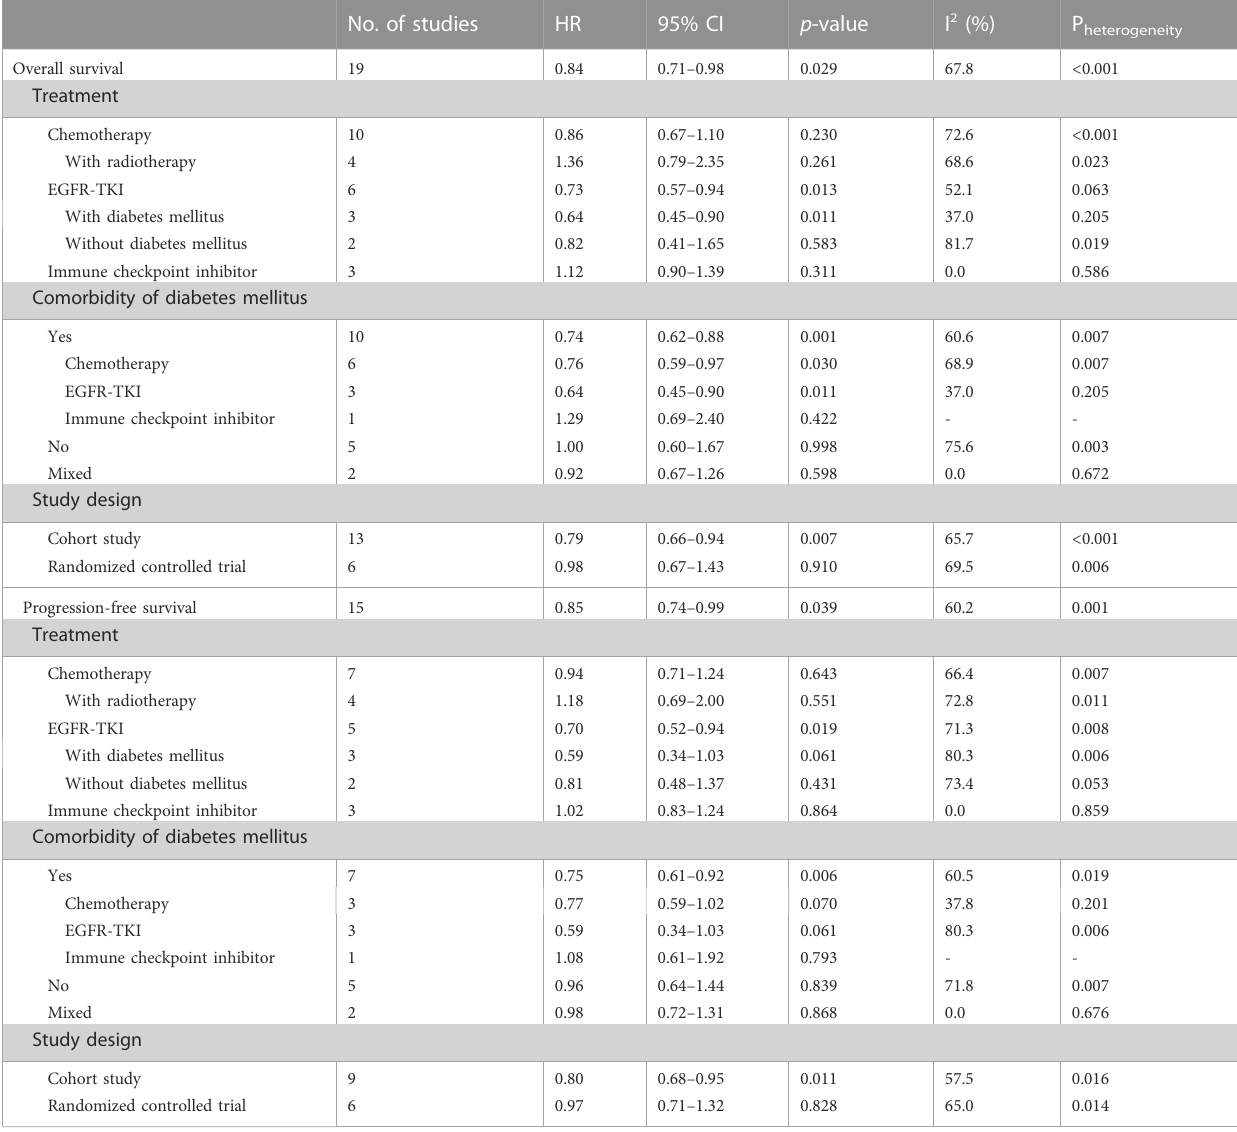
TABLE 2 Results of